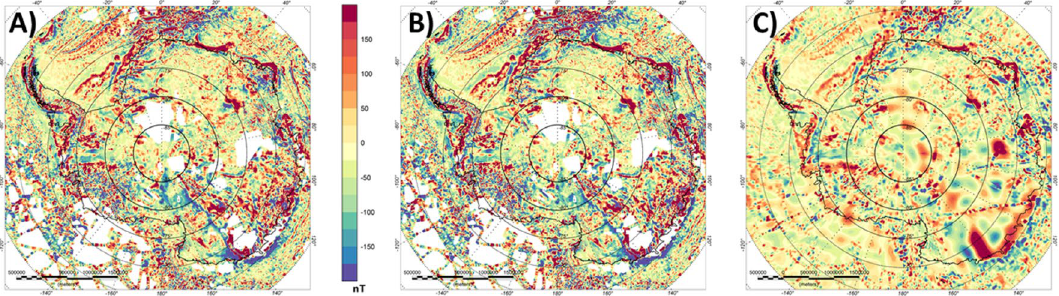
Figure 3. Lithospheric magnetic anomaly for Antarctica. ( A ) Original ADMAP-2 compilation 35 . ( B ) After conforming ADMAP-2 to the satellite model LCS-1. ( C ) EMAG2v3 17